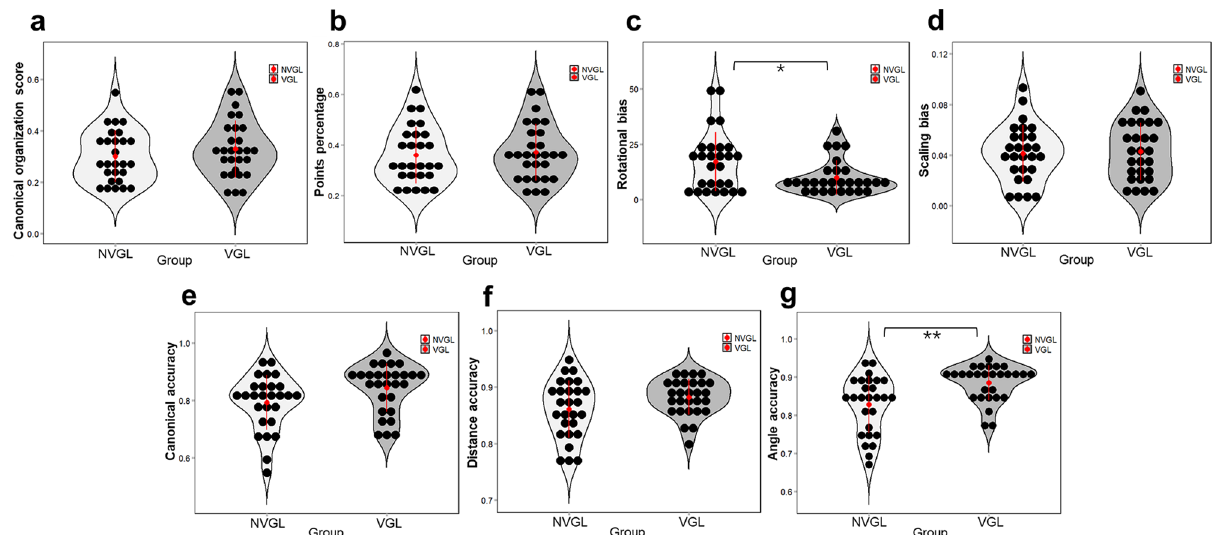
Figure 4. Single index scores for the VGL and NVGL groups in the map drawing task. The indexes include: (a) canonical organization score, (b) recalled points percentage, (c) rotational bias, (d) scaling bias, (e) canonical accuracy, (f) distance accuracy, and (g) angle accuracy. Each dot of the scatter plot indicates the average value for one participant. The black dots represent means, and the error bars indicate standard deviations. *: p < .05 and ***: p <